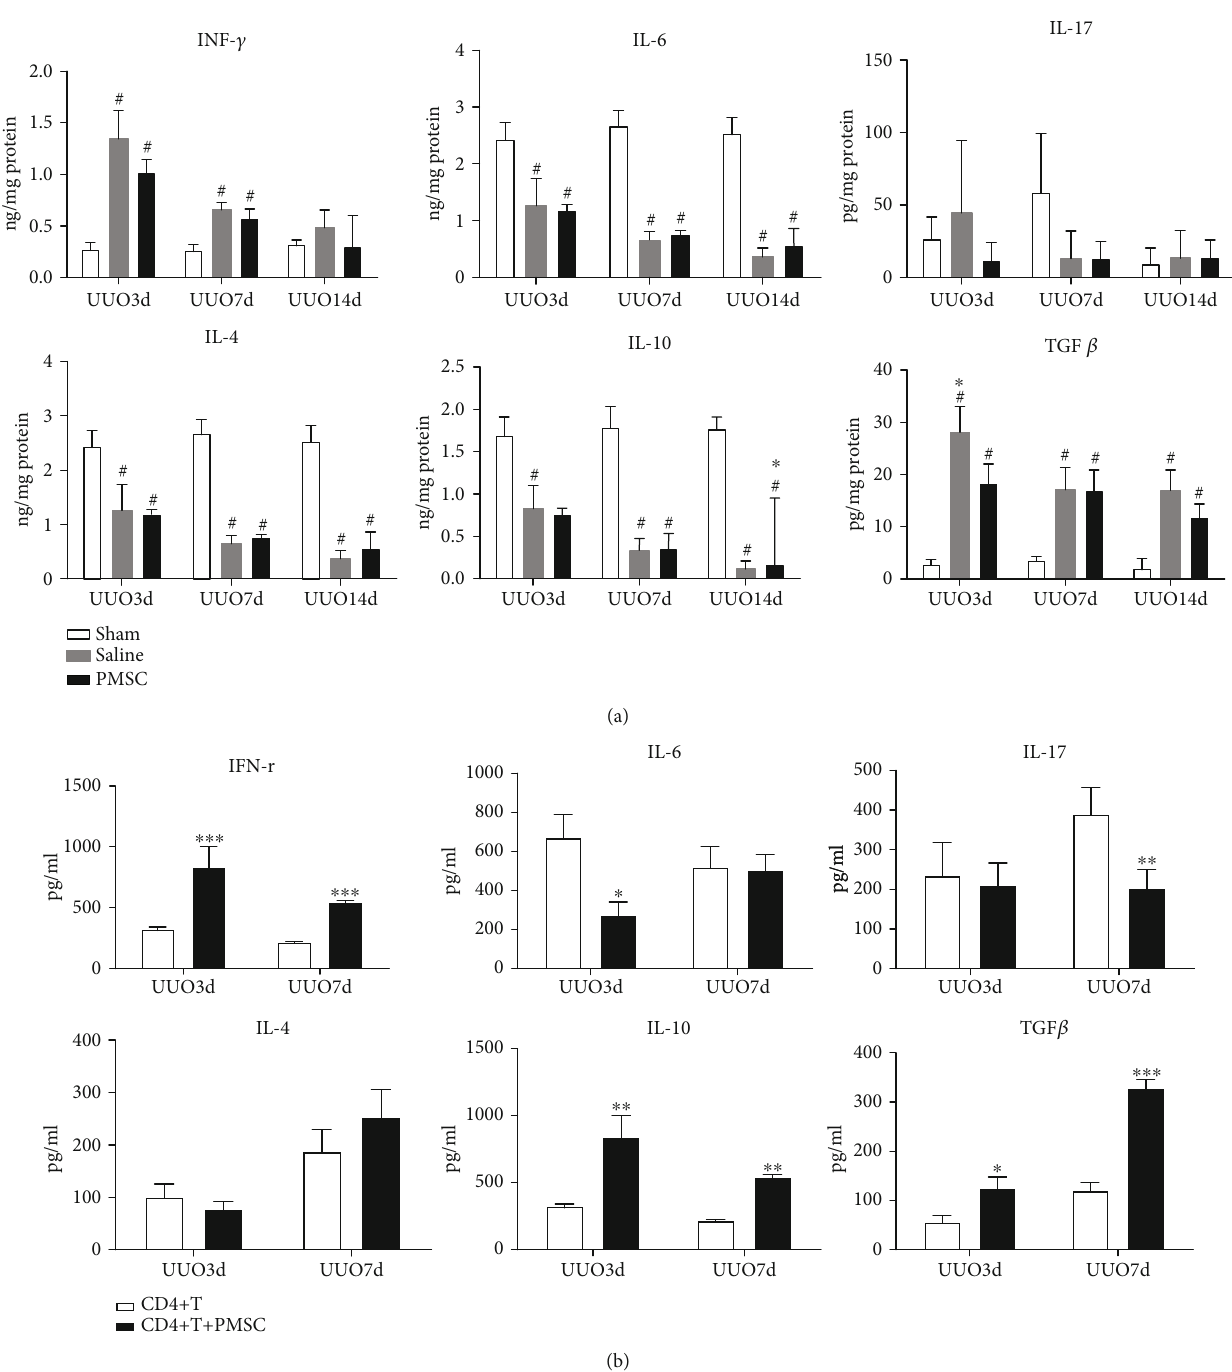
Figure 5: PMSCs regulate the expression of in fl ammatory cytokines including IFN- γ , IL-4, IL-6, IL10, IL-17, and TGF- β in vivo and vitro. (a) ELISA analysis was performed to detect cytokines expression both from renal tissue homogenate and (b) in vitro experiments. (b) In fl ammatory factors tested from cell supernatant of CD4 + T cells extracted from PMNC of rats at days 3 and 7 after UUO with or without PMSC coculture ( n = 4 ). ∗ P < 0 : 05 compared with CD4 + T cells group; ∗∗ P < 0 : 01 compared with CD4 + T cells group. ∗∗∗ P < 0 : 001 compared with the CD4 + T cells